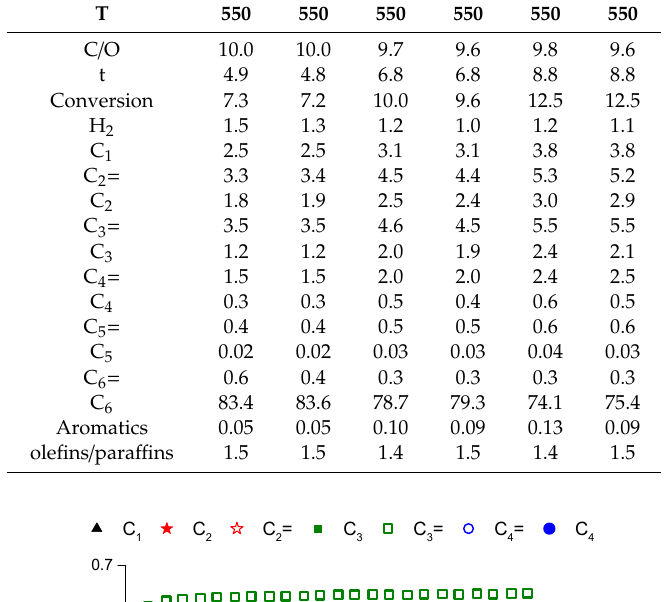
Table A1. Experimental results from riser simulator recorded at 550 ◦ C at di ff erent residence time. T 550